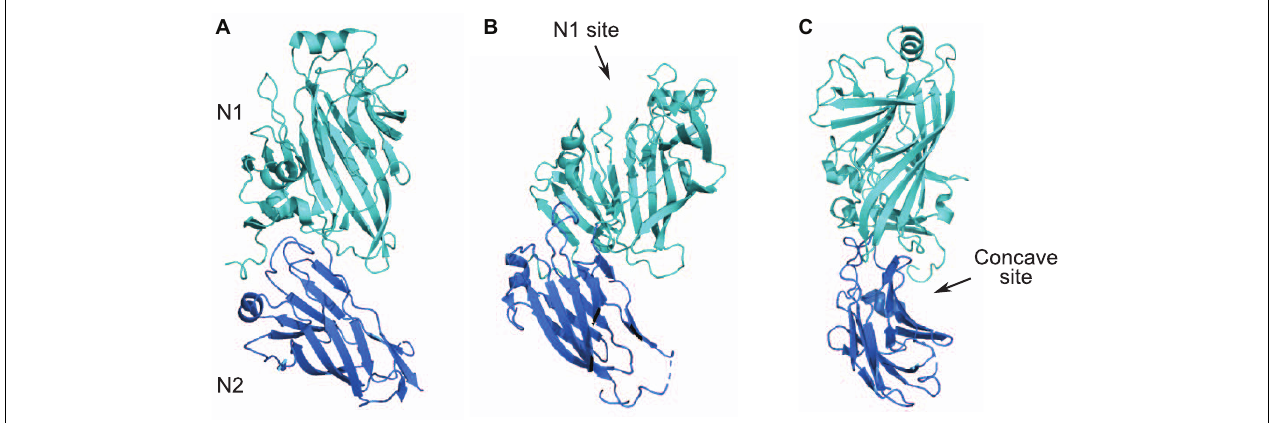
FIGURE 4 | N1N2 domains of Sgo0707. (A) N1 and N2 domains of Sgo0707 from S. gordonii [PDB code: 4IGB (Nylander et al., 2013)] are shown in light teal and dark blue, respectively. (B) Figure shows predicted collagen binding site present in the N1 domain. (C) Figure shows second predicted collagen binding site formed the loops of the N1 domain and a β -sheet of the N2 domain. This site forms a concave surface where collagen can